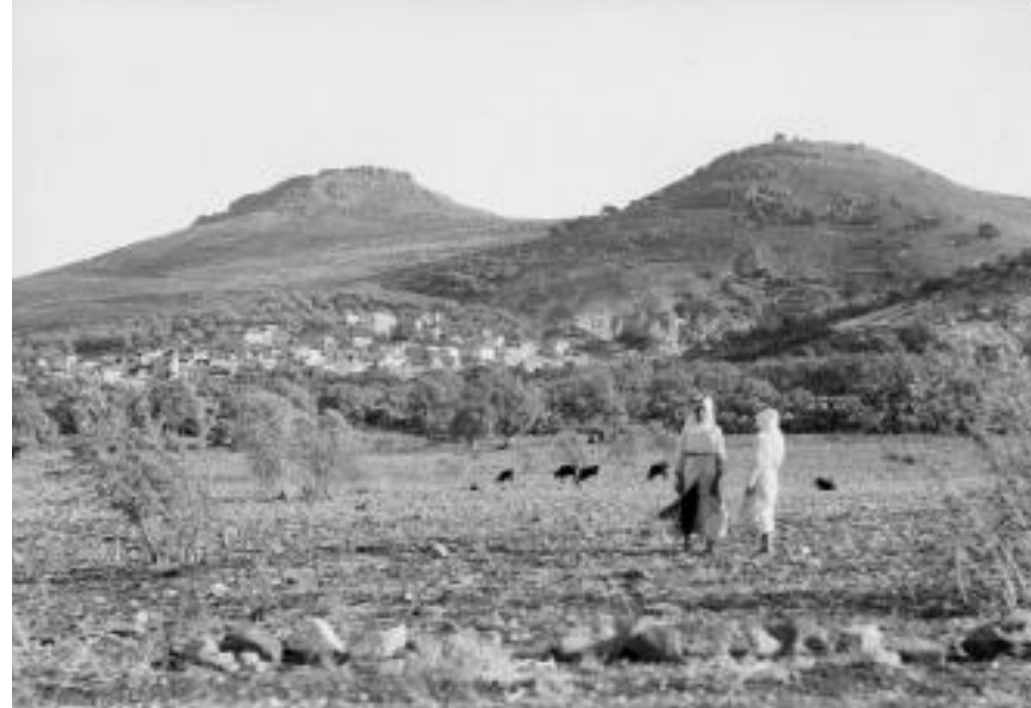
Figure 3. The Horns of Hattin in an old photograph (Photograph taken from Matson Registers, v. 1, [1934–1939]; 1 January 1934; downloaded 10 January 2020: https://picryl.com/media/galilee-tiberias-and-hattin-867b8c).